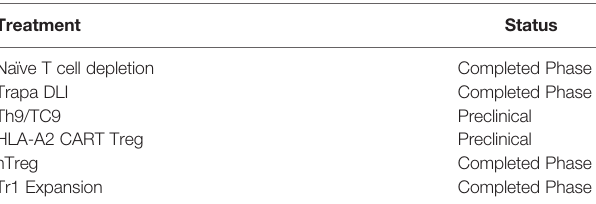
TABLE 1 | Summary of Cellular Therapies for GVHD based on T cells